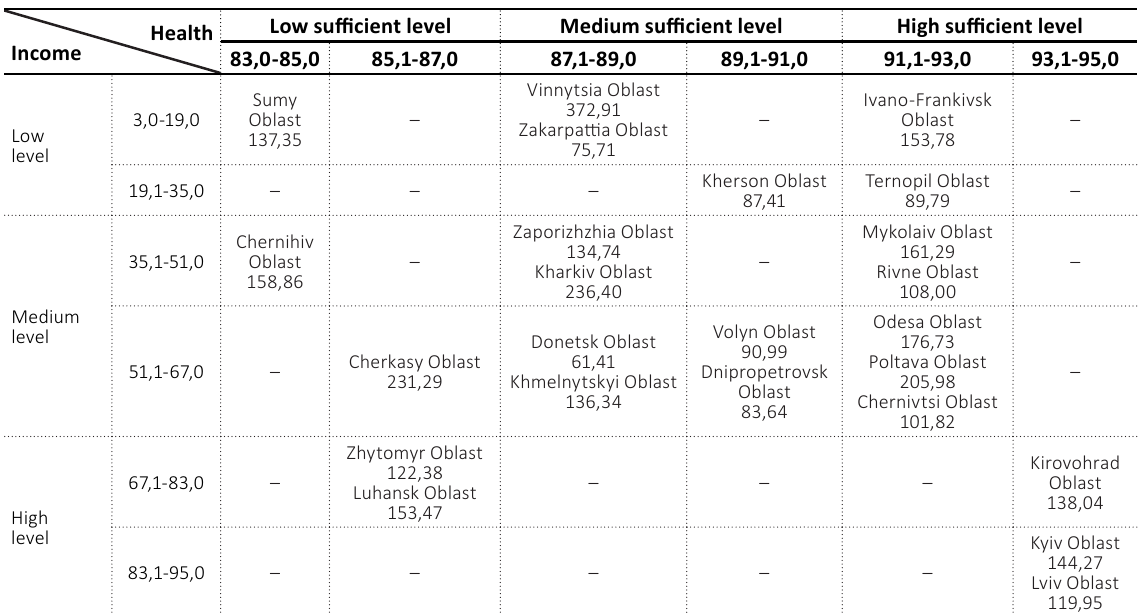
Table 3. Payoff matrix by region